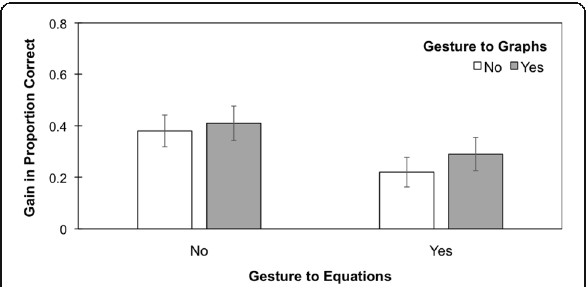
Fig. 2 Average unadjusted gains in proportion correct on translation items from pretest to posttest, as a function of condition. The error bars represent standard